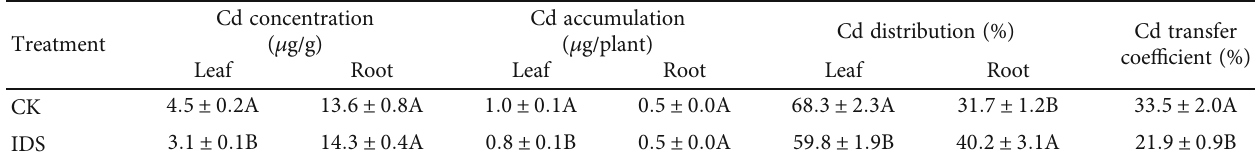
Figure 1: The e ff ects of IDS on dry mass and pigment content in rapeseed under Cd stress. Mean ± SD ( n = 5 ). Di ff erent uppercase letters (A, B) indicate signi fi cant di ff erence between CK and IDS treatment at P < 0 : 05 . Table 1: The e ff ects of IDS on Cd concentration and distribution in rapeseed seedlings. Mean ± SD ( n = 5 ). Di ff erent capital letter indicates signi fi cant di ff erence between these two treatments at P < 0 : 05